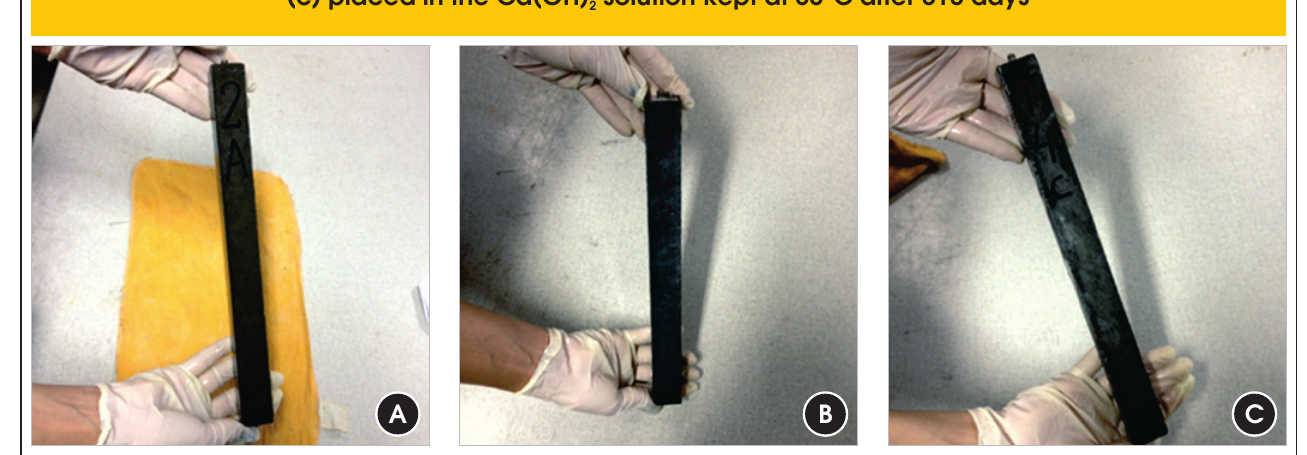
Figure 5 – Prismatic bars used in the expansion evaluation (a) placed in curing room after 327 days – (b) placed in the Ca(OH) solution kept at room temperature after 320 days 2